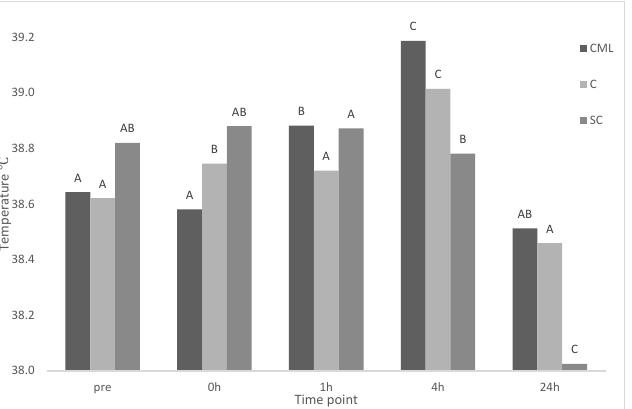
Figure 1. Maximum eye temperature of treatment groups castration + analgesia (CML), castration (C), and sham control (SC) ( n = 8 for all treatments) across time points pre (baseline), 0, 1, 4, 24 h. Means between time points within a treatment group (column) with differing superscripts ABC are significantly different. 3.3. Reaction Scores to Castration There was a significant effect of treatment on the behavioural response to scrotal in- cision ( p < 0.001). The SC group was most likely to not respond (score 0) to scrotal manip- ulation compared to CML and C groups (Table 4). A significant effect of treatment was observed for both removal of testes 1 and 2 ( p < 0.01 and p = 0.04, respectively). Regarding removal of the first testis (right), SC group were more likely to score 0, C group were more likely to receive the highest score of 3, and CML a score of 2 (Table 4). For overall reaction to the procedure (Table 4), no treatment effect was found ( p = 0.1). However, the trend of SC group lambs scoring lower than C and CML groups was still apparent. Table 4. Probability of lambs in different treatment groups (castration + analgesia (CML), castra- tion (C), and sham control (SC) ( n = 8 for each treatment)) reacting to stages of castration—scrotal incision, removal of testis 1 (right), removal of testis 2 (left)—and overall reaction to castration procedure.